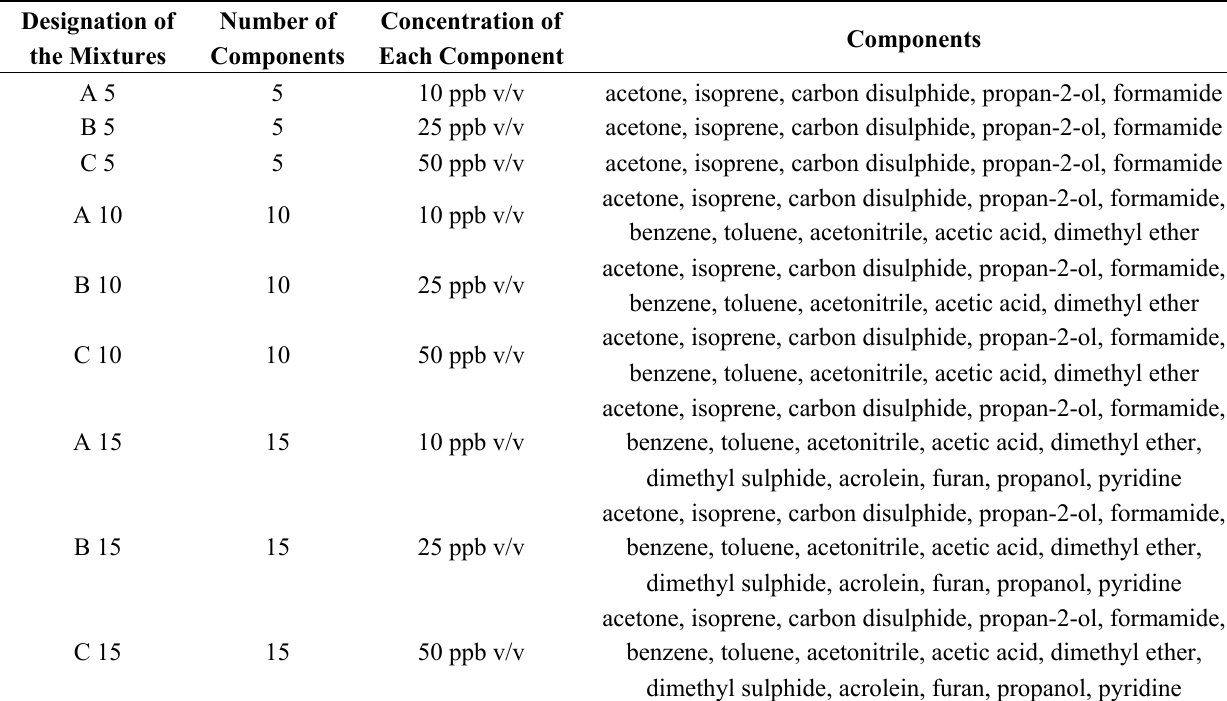
Table 1. Composition of reference